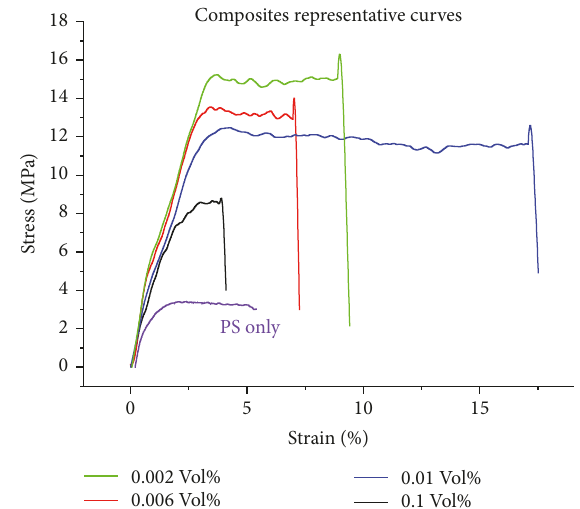
Figure 4: Representative stress-strain curves for the MoS 2 -PS composites.